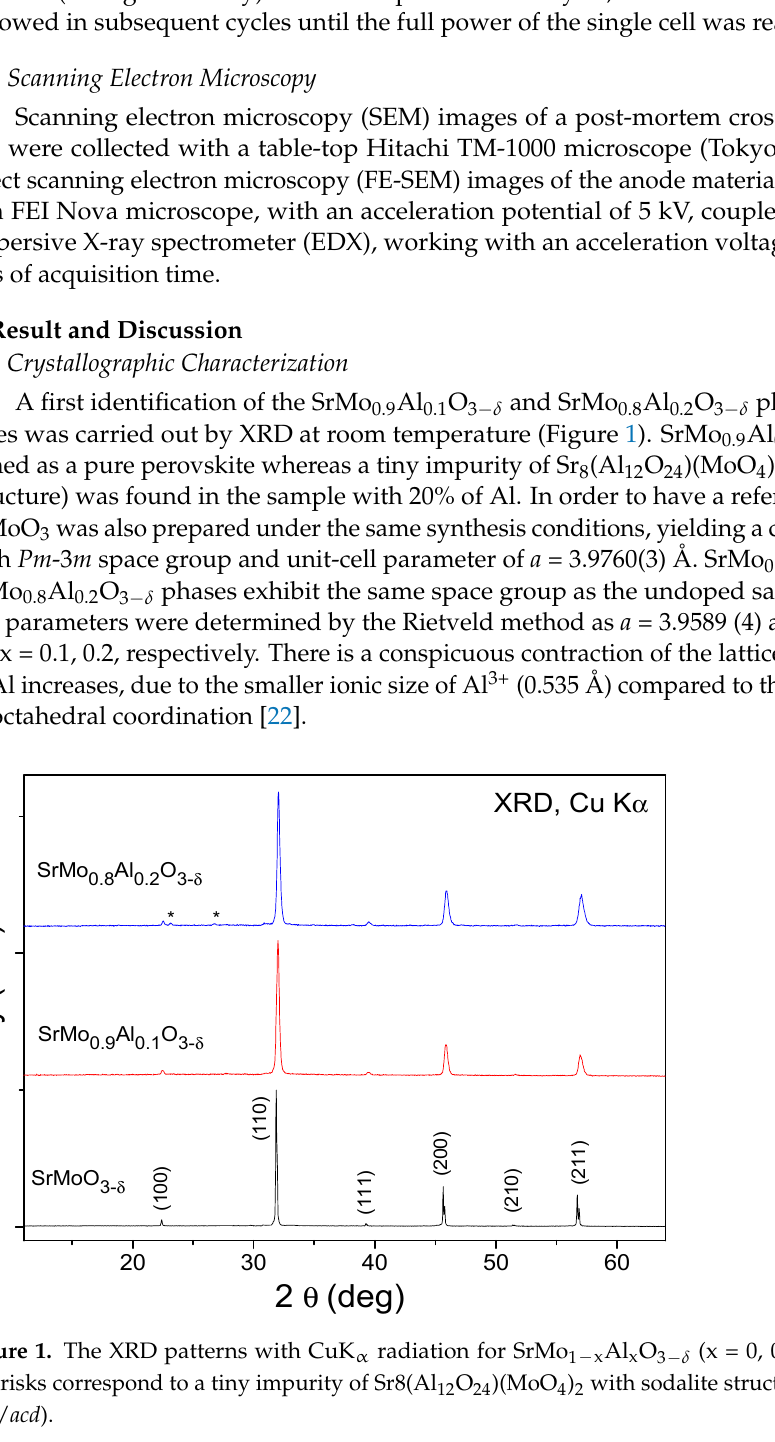
Figure 2. Observed (crosses), calculated (full line), and difference (at the bottom) NPD profiles for ( a ) SrMo 0.9 Al 0.1 O 3 − δ and ( b ) SrMo 0.8 Al 0.2 O 3 − δ at 25 °C, refined in the cubic Pm-3m space group. The vertical markers indicate the allowed Bragg reflections. The second series of Bragg reflections cor- responds to a second perovskite phase with a higher amount of Al. The third series for x = 0.2 be- long to Sr 8 (Al 12 O 24 )(MoO 4 ) 2 with sodalite structure. ( c ) View of the cubic perovskite crystal struc-